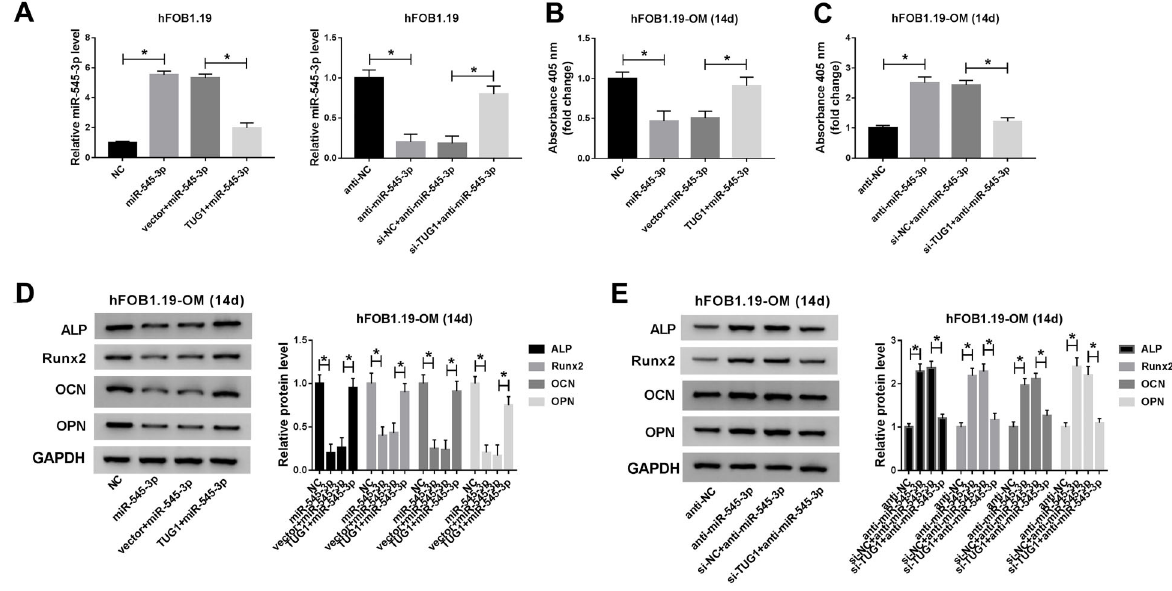
Figure 6. TUG1 restored the effect of miR-545-3p on osteogenic differentiation. A , Expression of miR-545-3p was measured in hFOB1.19 cells transfected with negative control (NC), miR-545-3p, vector + miR-545-3p, or TUG1 + miR-545-3p. Also, miR-545-3p expression was tested in hFOB1.19 cells transfected with anti-NC, anti-miR-545-3p, si-NC + anti-miR-545-3p, or si-TUG1 + anti-miR- 545-3p. B , The activity of ALP was detected in osteogenic differentiated hFOB1.19 cells following miR-545-3p upregulation and/or TUG1 upregulation. C , ALP activity was examined in osteogenic differentiated hFOB1.19 cells after miR-545-3p down-regulation and/or TUG1 down-regulation. D , Protein levels of ALP, Runx2, osteocalcin (OCN), and osteopontin (OPN) were analyzed in osteogenic differentiated hFOB1.19 cells transfected with miR-545-3p and/or TUG1. E , The levels of ALP, Runx2, OCN, and OPN were tested in osteogenic differentiated hFOB1.19 cells introduced with anti-miR-545-3p and/or si-TUG1 by western blot assay. Data are reported as means ± SD of three independent experiments. *P o 0.05